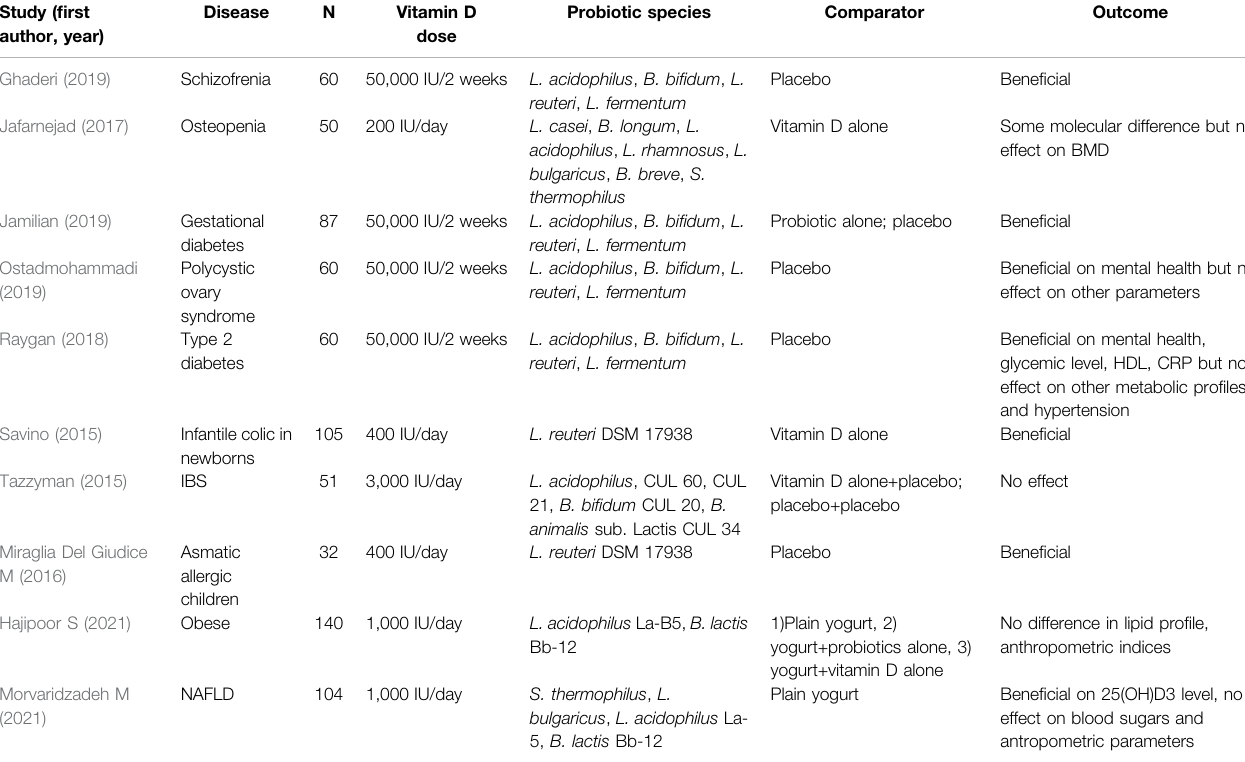
TABLE 1 | Randomized clinical trials (RCTs) investigating the effect of co-administration of probiotics and vitamin D in different clinical conditions; no trial, at present, evaluated the effect of probiotic plus vitamin D in IBD patients. Study ( fi rst author,